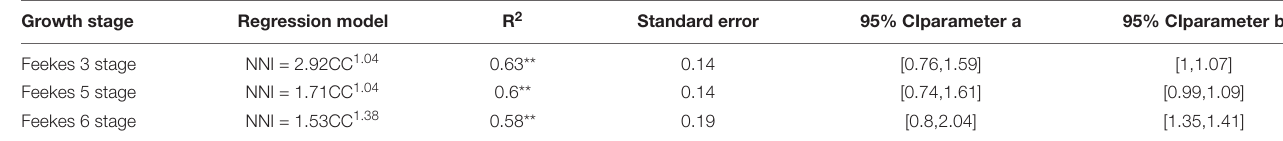
FIGURE 4 | The relationship between canopy cover and nitrogen nutrition index across different growth stages of winter wheat (A) the whole vegetative stages; (B) Feekes 3; (C) Feekes 5; (D) Feekes 6. TABLE 6 | The relationships between nitrogen nutrition index and canopy cover across different growth stage using the direct